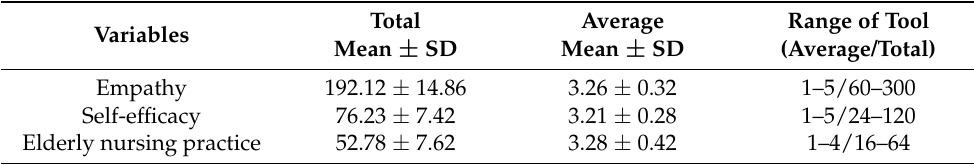
Table 2. Levels of empathy, self-efficacy, and elderly nursing practice.